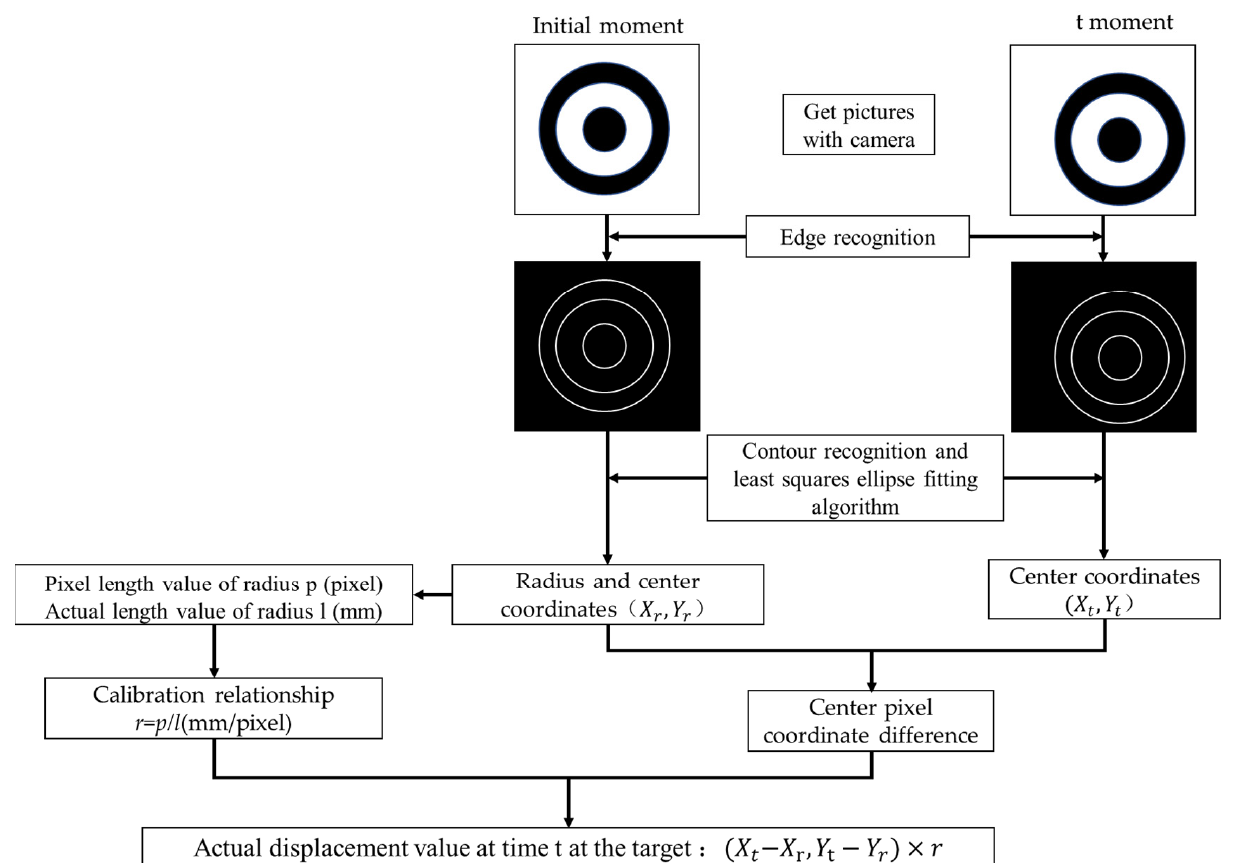
Figure 2. Schematic Diagram of Edge Detection Test Principle. The main methods for sub-pixel level edge-extraction algorithms are the moment method, fitting method, and interpolation method. In order to prioritize the accuracy results, the sub-pixel edge-detection algorithm based on Zernike moments [24] was chosen in this paper. Its step model is shown in Figure 3, and there are four relevant parameters, where k is the grayscale difference of the step edge, characterizing the recognition accuracy; h represents the grayscale value of the background side; l denotes the minimum distance from the origin to the edge, which is used to characterize the thickness of the edge; and ϕ is the angle between the edge and the x -axis. The formula for calculating the four parameters of a pixel point in a grayscale image is as follows.